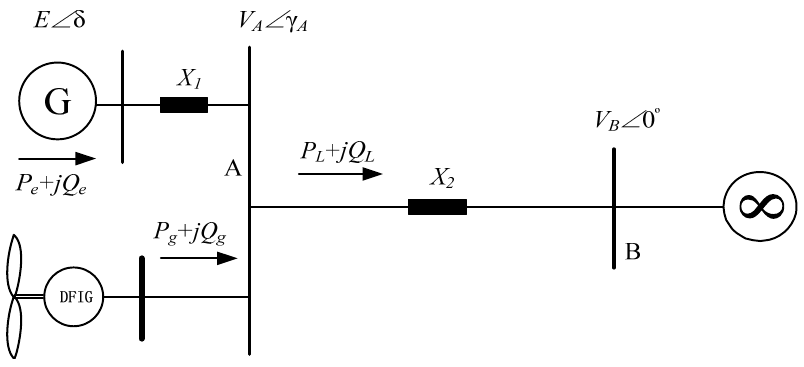
Figure 3. Schematic of the simplified system